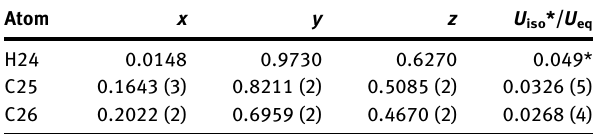
Table  : Fractional atomic coordinates and isotropic or equivalent isotropic displacement parameters (Å 